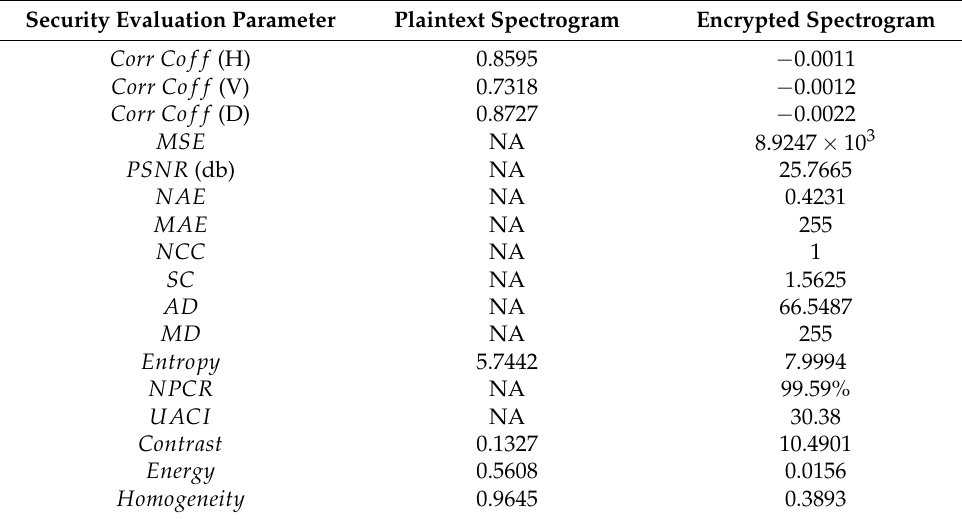
Table 6. Security analyses of the encrypted spectrogram: blue